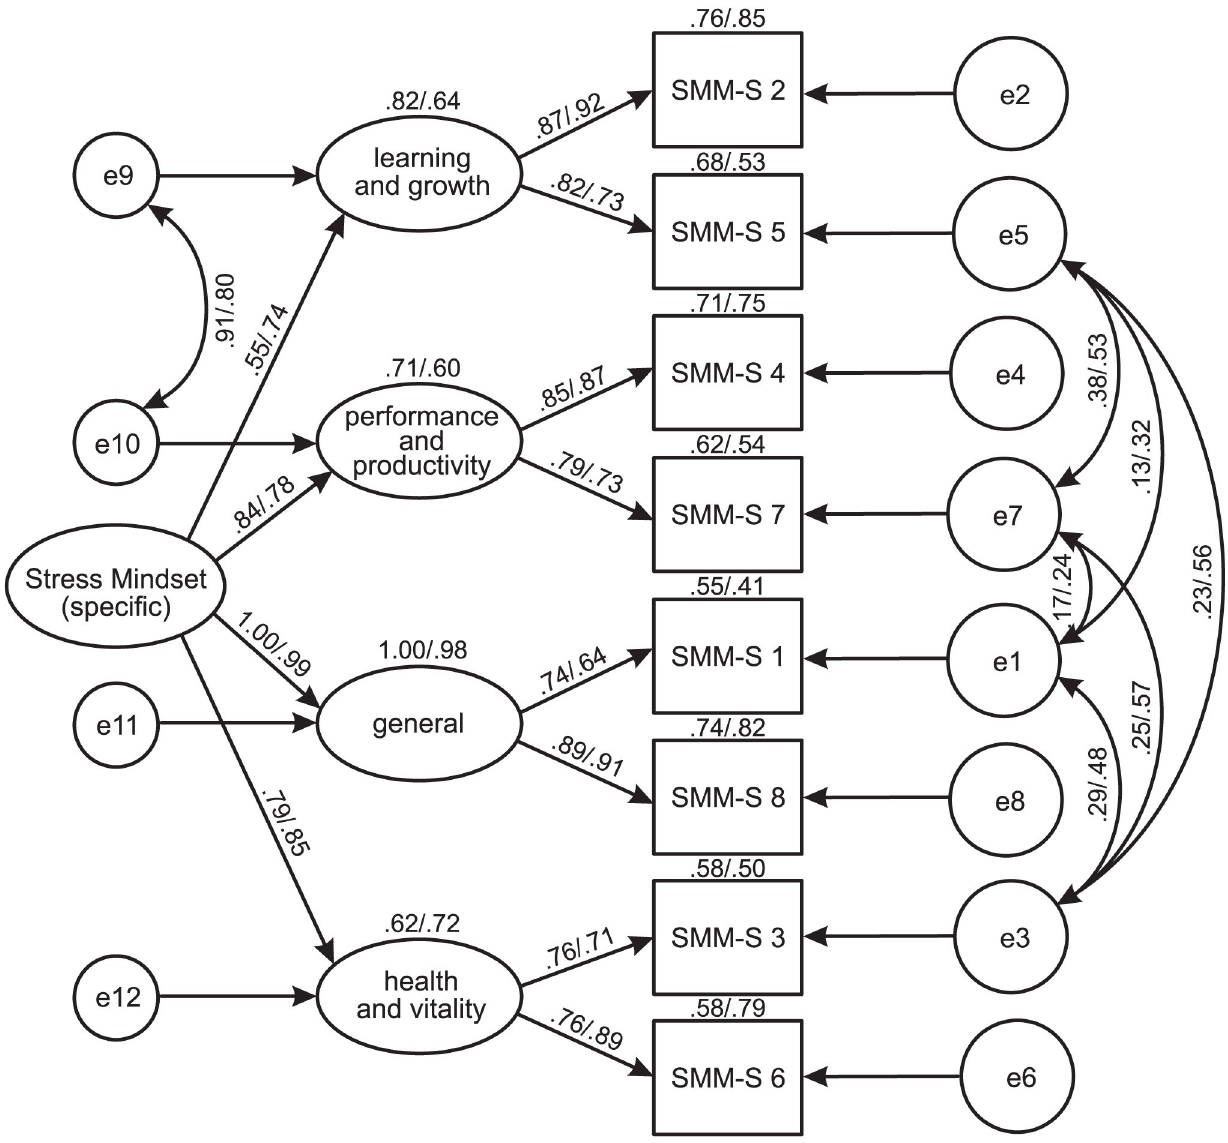
Fig 2. SMM-S: Results of CFA for a hierarchical four-factor model (Study 1 and Study 2, standardized solutions). SMM S, the Stress Mindset Measure- Specific ; SMM-S (1–8), items of a scale; Learning and Growth, subscale concerning beliefs of stress consequences for learning and growth; General, subscale concerning beliefs of stress consequences for overall life; Performance and Productivity, subscale concerning beliefs of stress consequences for performance and productivity; Health and Vitality, subscale concerning beliefs of stress consequences for health and vitality; e,